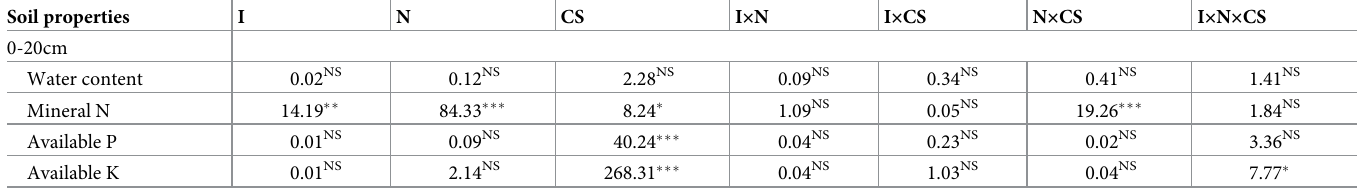
Table 2. Analysis of variance of the effects of irrigation (I), nitrogen fertilization (N) and cropping season (CS) on soil properties. Soil